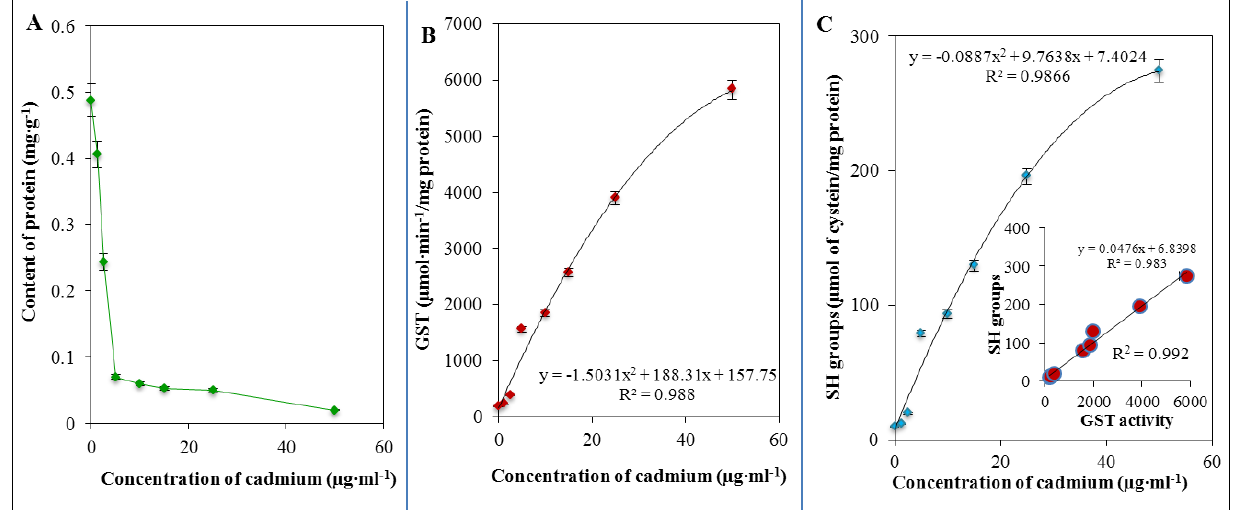
Figure 6. Spectrophotometric determination of ( A ) total proteins content by the Biuret method, ( B ) GST activity and ( C ) concentration of free –SH moieties; in inset: correlation between GST activity and free –SH moieties concentration. Other experimental conditions are given in Figure 4 and in the Experimental